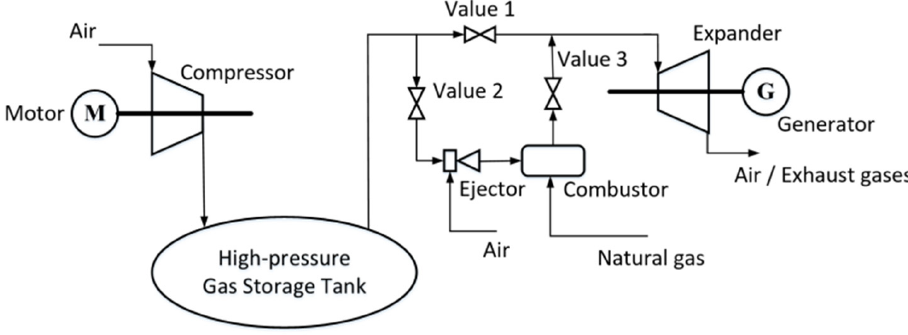
Figure 2. Diagram of compressed-air energy storage system with an ejector and combustor.